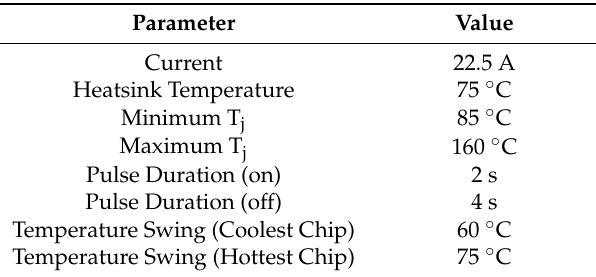
Table 1. Power Cycling Test Parameters.